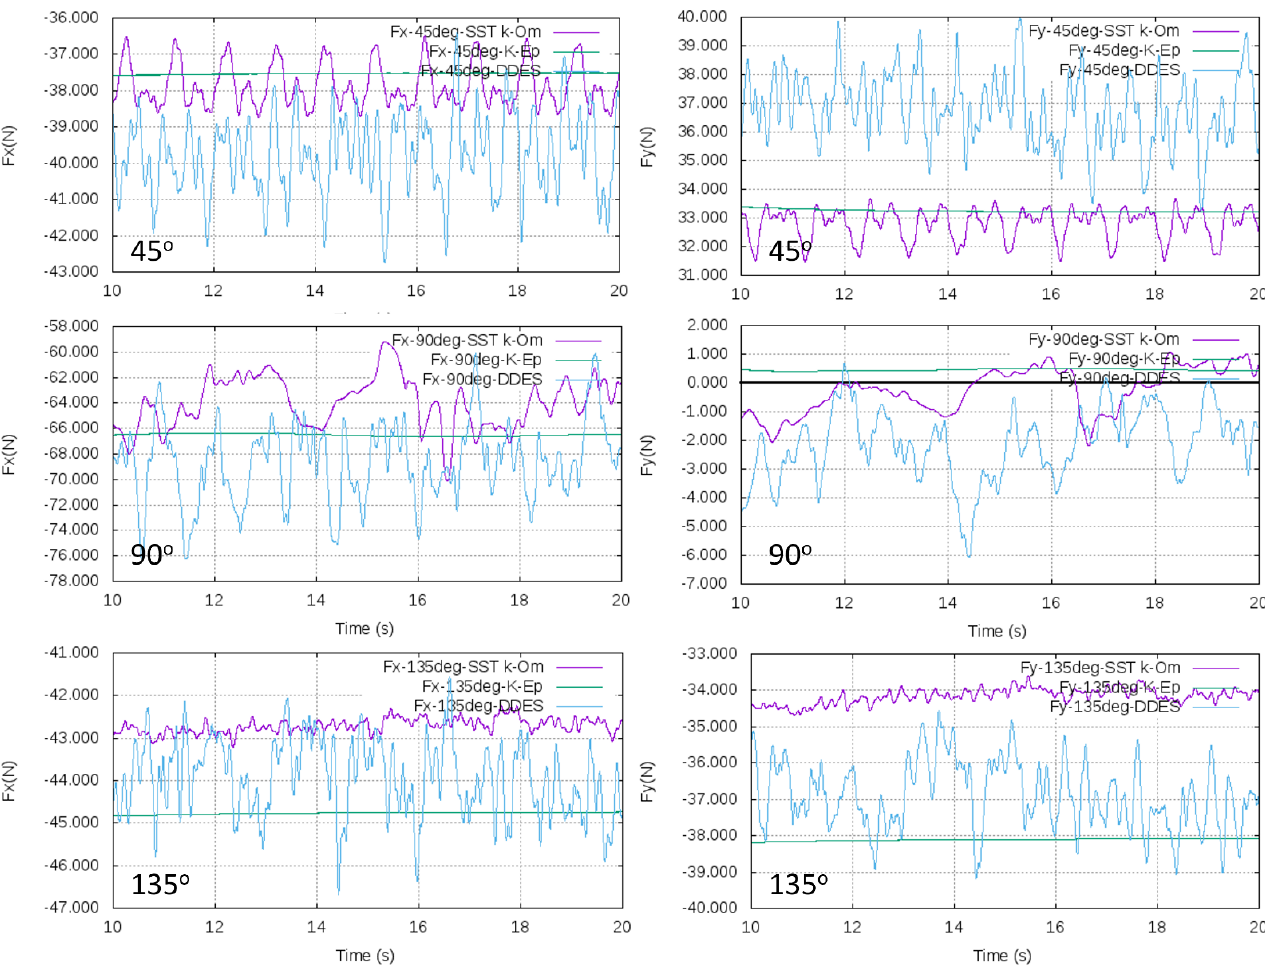
Figure 4. Relative comparison among force time histories for the Tejo vessel model simulated using three different turbulence models. In the figure, the purple colour represents the SST K-Omega model, green represents the K-Epsilon model, and blue represents the DDES model.